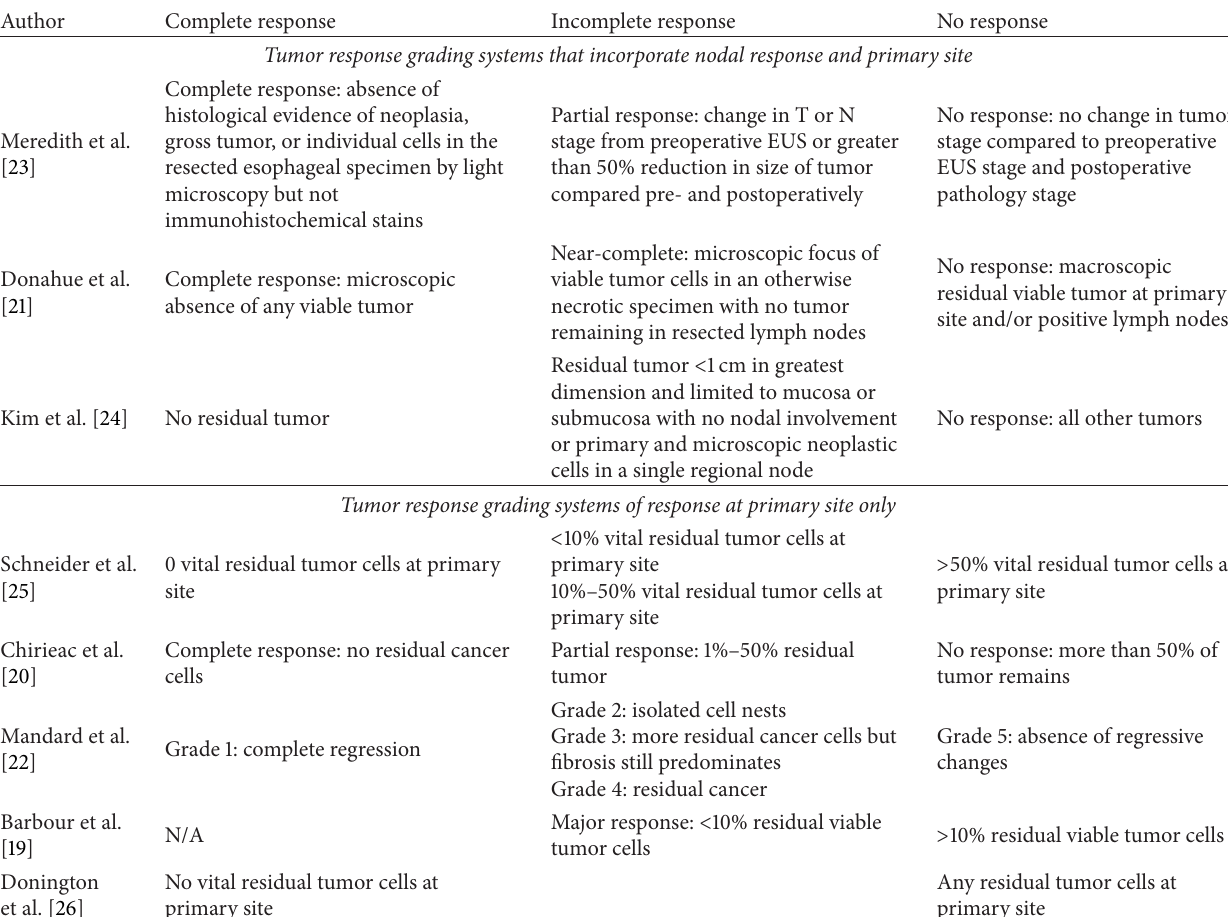
Table 1: Tumour response grading